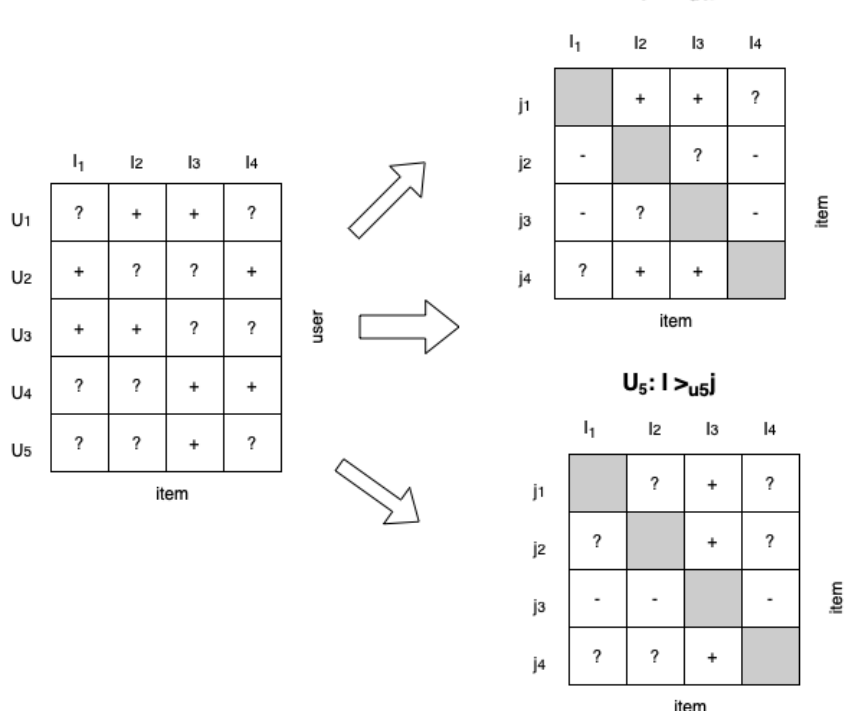
Figure 2. The creation of user specific pairwise preferences between pair of items showing the pref- erence of the user for item i over j.